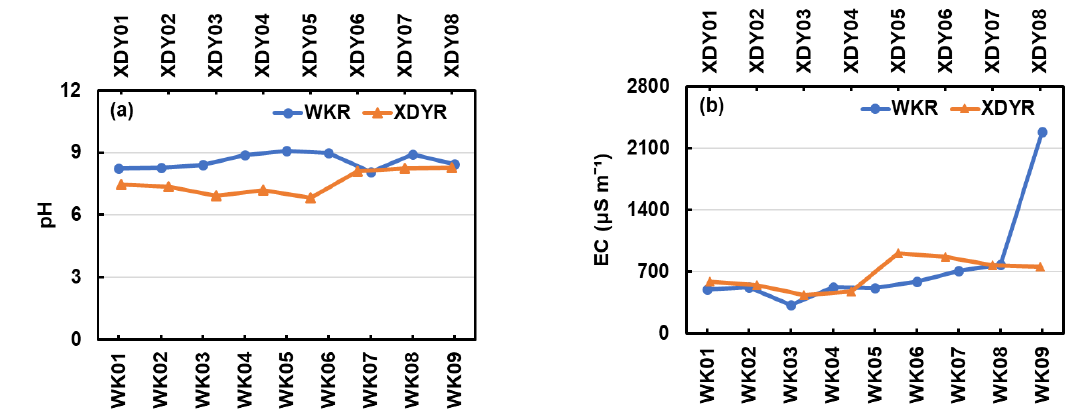
Figure 2. Spatial distribution of ( a ) pH and ( b ) electrical conductivity (EC) of the sampling sites in the WangKuai reservoir route (WKR) and XiDaYang reservoir route (XDYR).